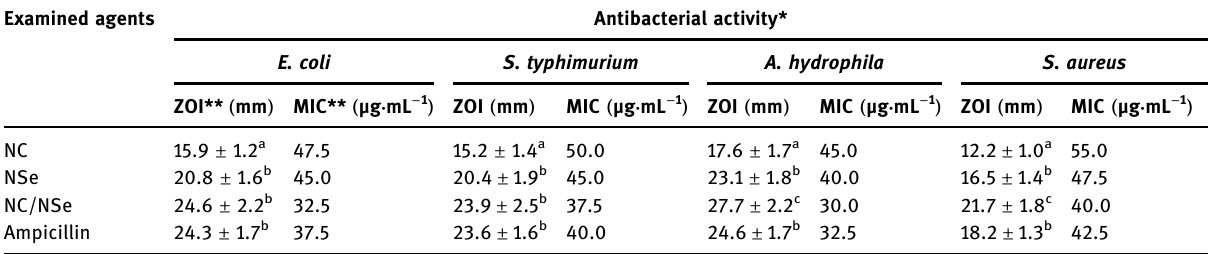
*Signi fi cant di ff erence ( at p ≤ 0.05 ) is indicated by various superscript letters in one column. **ZOI: mean diameter of inhibition zones in